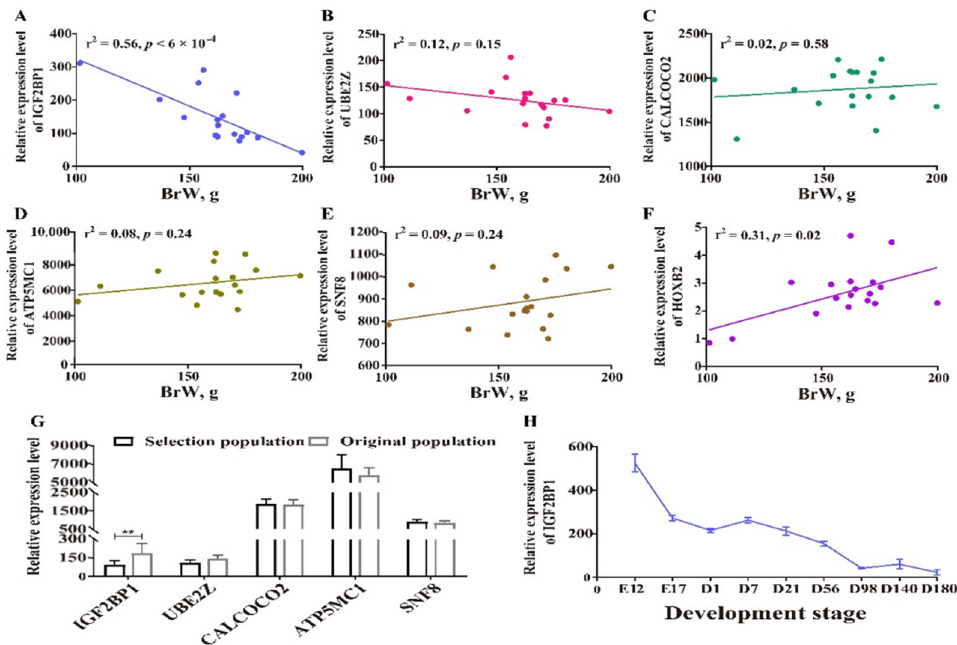
Figure 6. Transcriptomic analysis for candidate genes. ( A – E ) Correlation analysis between BrW and genes IGF2BP1 , UBE2Z , CALCOCO2 , ATP5MC1 , and SNF8 , respectively. ( F ) Comparison for BrW from the individuals performing the RNA-seq ( n = 9 each population). ( G ) Differentially expressed genes analysis for IGF2BP1 , UBE2Z , CALCOCO2 , ATP5MC1 , and SNF8 between two lines, ** indicates p < 0.01. ( H ) Stage-based expression pattern of IGF2BP1 , E indicates embryo stage, D indicates the age of after hatching.